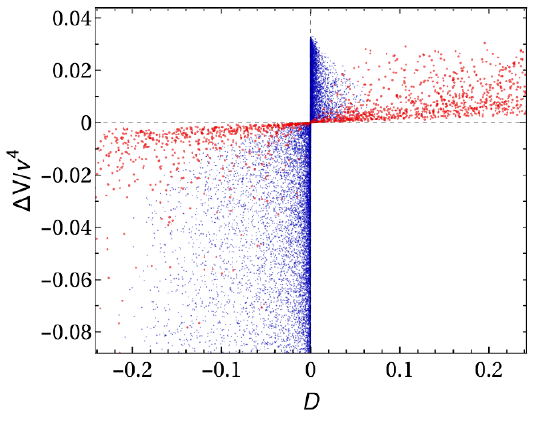
Figure 2 . Normalized potential di(cid:11)erence (2.4) at the two coexisting minima against the discrim- inant